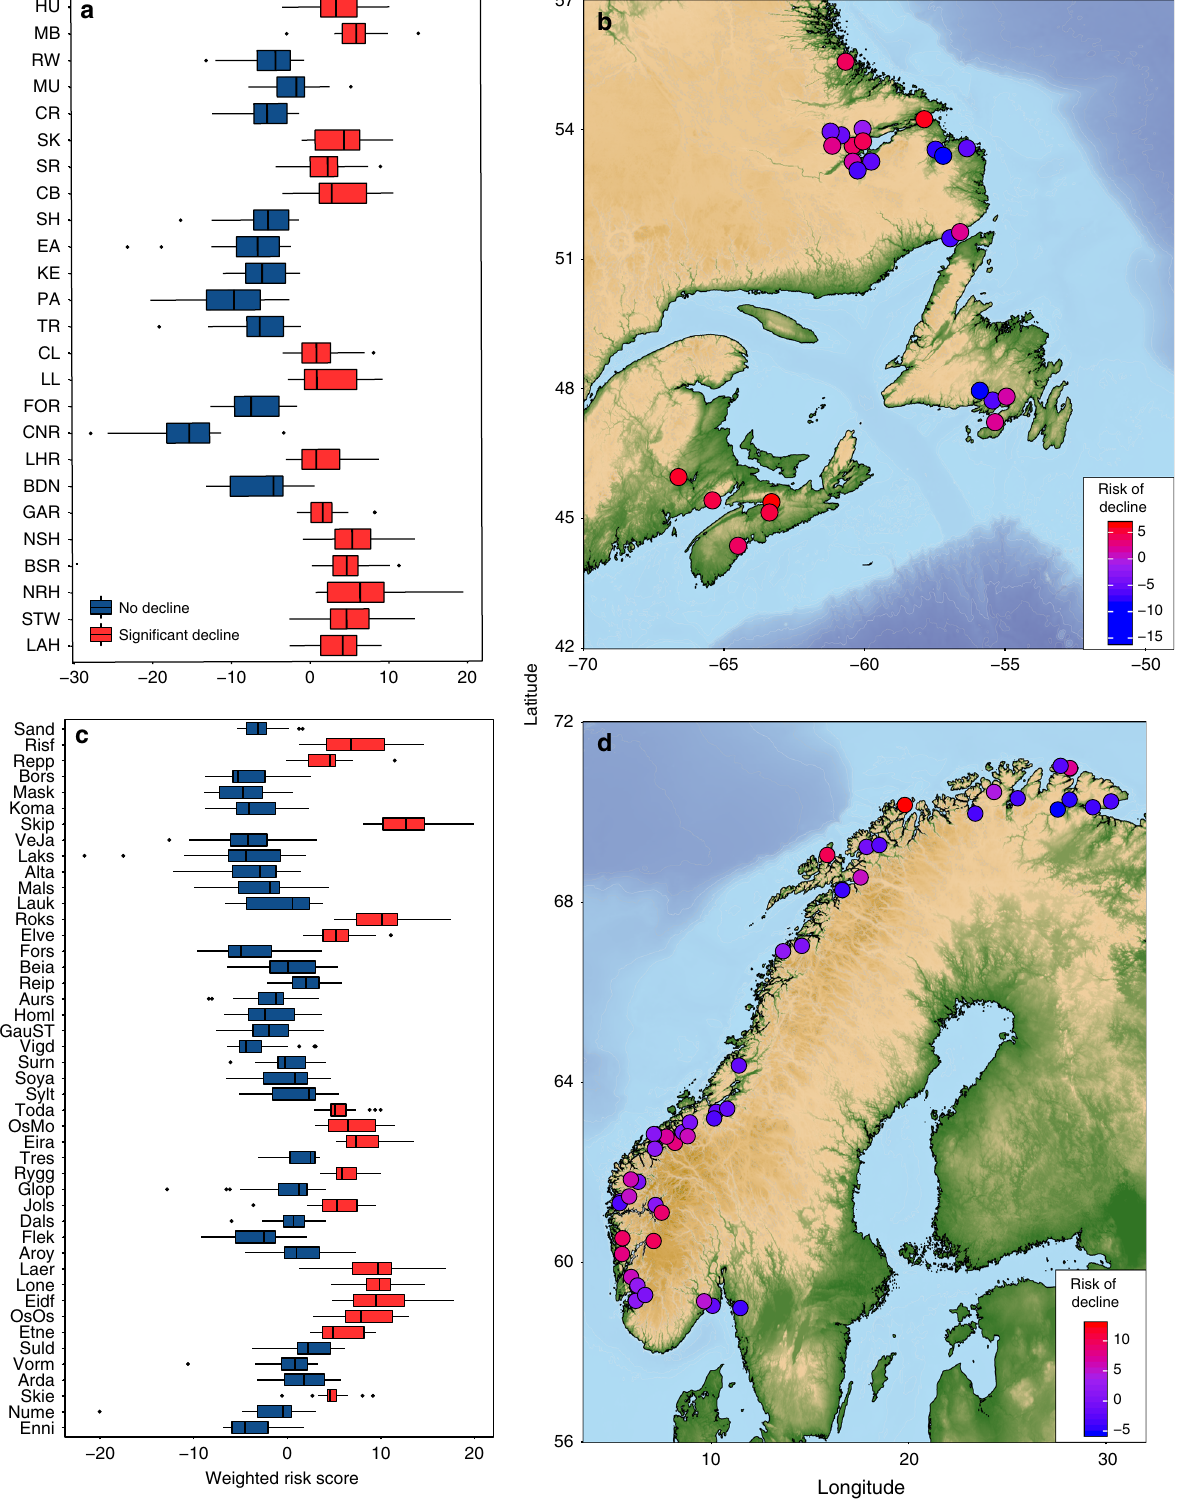
Fig. 4 Predicting risk of declines across Atlantic salmon populations. Boxplots of weighted polygenic risk scores for population declines in ( a ) North America and ( c ) Europe calculated from decline-associated loci (RDA) in PredictABEL. Populations are arranged by latitude. For boxplots, centre line indicates median risk score, box limits represent upper and lower quartiles, whiskers indicate 1.5 × interquartile range, and points outside this range are outliers. Maps show mean score values for each population in ( b ) North America and ( d ) Europe. Maps were generated using National Oceanic and Atmospheric Administration (NOAA) bathymetry data from the R package marmap